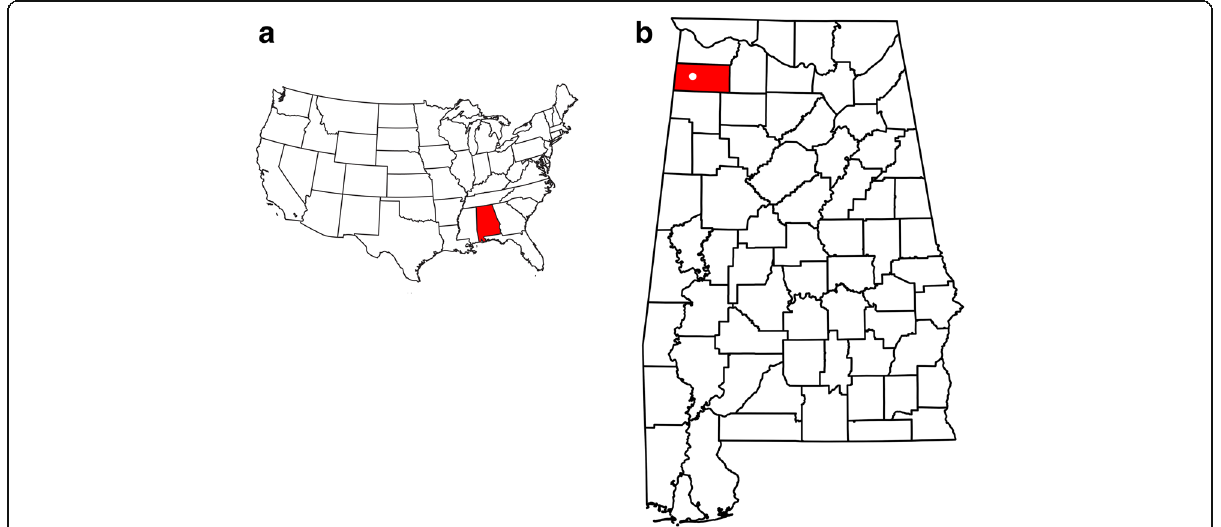
Fig. 4 a Map of the United States, with the state of Alabama outlined. b Map of Alabama with Franklin County highlighted. White dot marks location where holotype of Arcuodus multicuspidatus was found